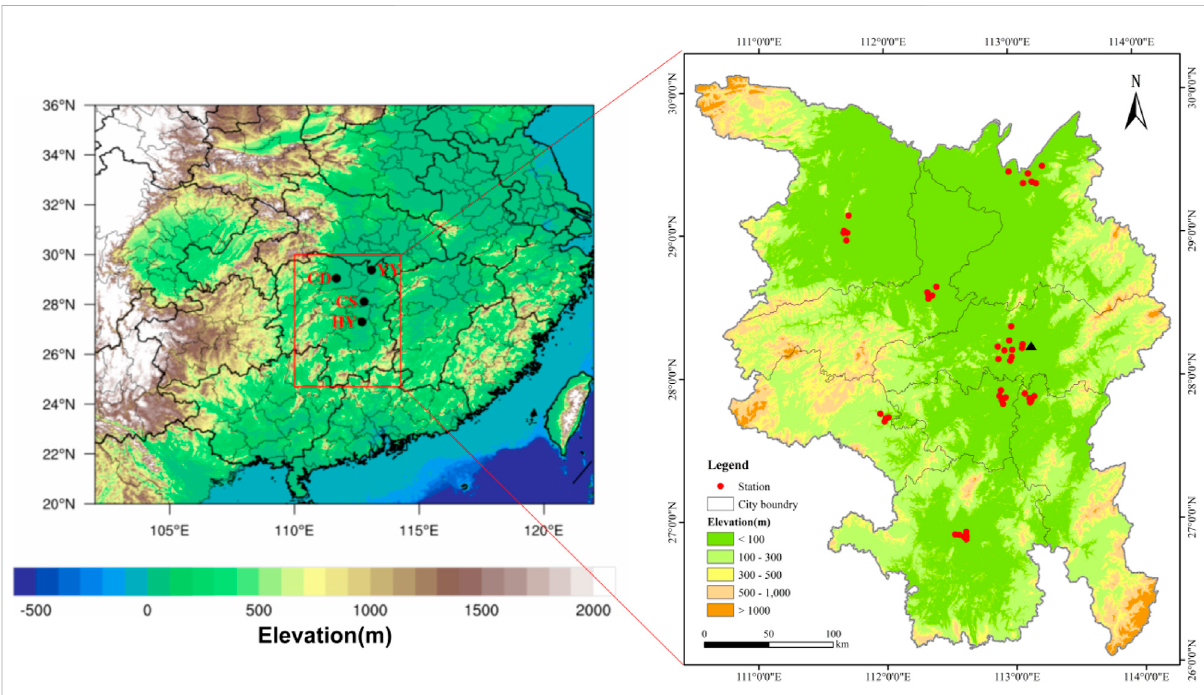
FIGURE 1 SurroundingterrainoftheCZTandthelocationofmeteo,environmentalmonitoringstationsandtheMapolingsoundingstation.Blackdotsare meteorological observation stations (CD presents Changde, YY presents Yueyang, CS presents Changsha and HY presents Hengyang), red dots are environmental monitoring stations, and black triangle is the sounding